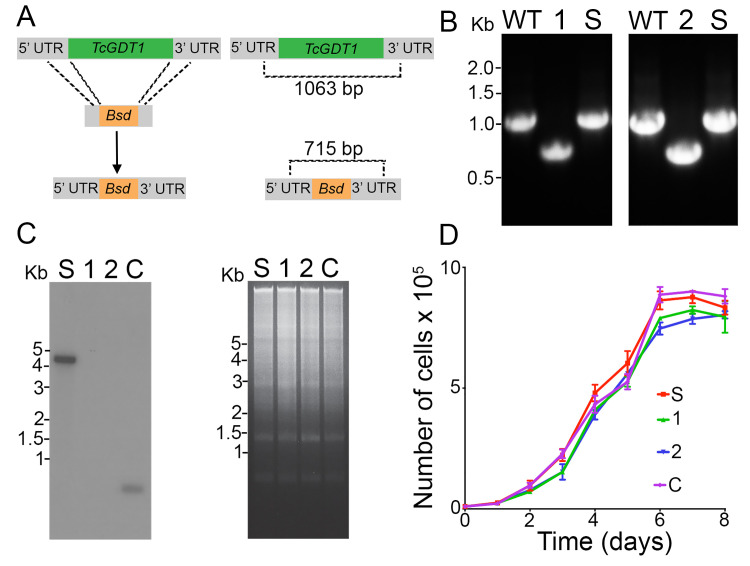
Knockout of TcGDT1.(A) Schematic representation of the strategy used to generate a TcGDT1-KO cell line by CRISPR/Cas9-mediated genome editing. A double-stranded gDNA break was produced by Cas9 at nt +14 of the TcGDT1 ORF. DNA was repaired with a blasticidin S-deaminase (Bsd) cassette containing 100-bp homologous regions from TcGDT1 5’- and 3’- UTRs. Regions amplified by the primers that were used to verify gene replacement by PCR are shown in the right panel. The intact locus generates a PCR product of 1,063 bp, while the replaced locus generates a fragment of 715 bp. (B) PCR analysis showing that TcGDT1 was ablated at its genomic locus and replaced in genomic DNA of the KO cell line. Lanes: WT, wild type; S, control parasites transfected with a scramble sgRNA; 1 and 2, clone 1 and clone 2 of TcGDT1-KO epimastigote. (C) Southern blot analysis of control (S), TcGDT1-KO clones 1 and 2 and complemented, C, epimastigote clones. The blot was hybridized with a 227-bp 32P labeled probe amplified from TcGDT1 ORF. The intact locus is detected as a 4 kb band which is missing in the TcGDT1-KO clones. A 0.5 kb band can be detected in the complemented clone. Ethidium bromide staining of the Southern blot gel indicating equal loading of DNA in all lanes is shown in the right panel. (D) Epimastigote growth of control (S), TcGDT1-KO cl. 1, or TcGDT1-KO cl. 2 and complemented TcGDT1-KO cl.1. Values are means ± s.d. of n = 3. There were no significant differences in growth by the different clones as compared to the control (S).